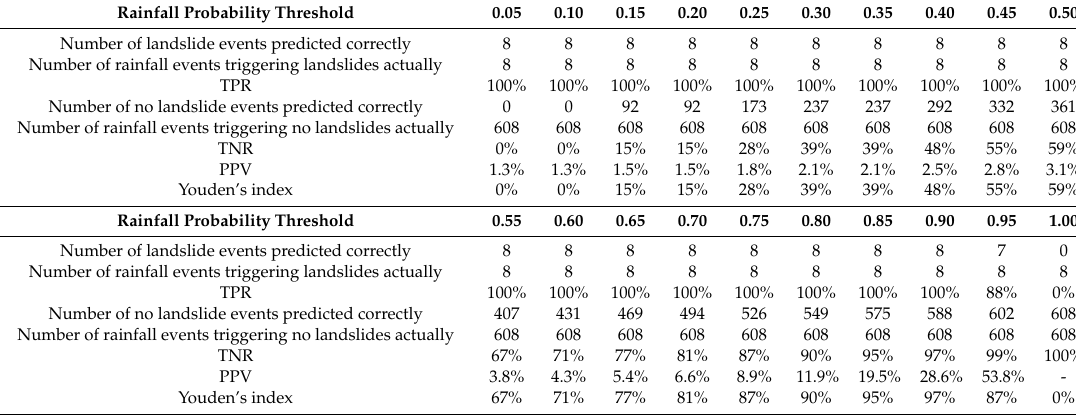
Table 2. True positive rate (TPR), true negative rate (TNR), positive predictive value (PPV), and Youden’s index for Bihu rain gauge at di ff erent rainfall probability thresholds.